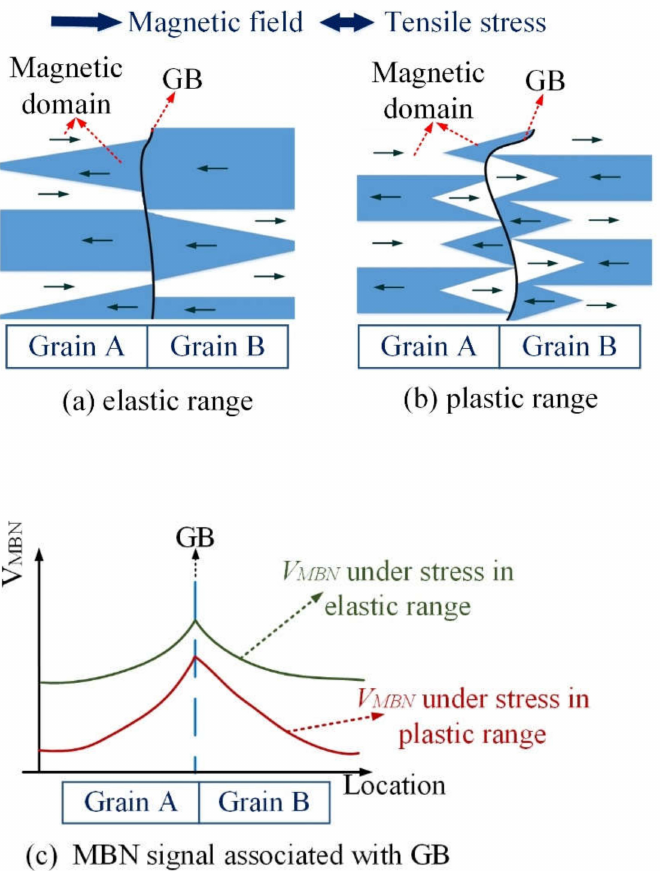
Figure 9. The schematic of domains interaction and MBN with GB under stress: ( a , b ) illustrate domain distribution around GB under stress in the elastic and plastic range, respectively; ( c ) illustrates MBN on the grain and GB under stress in the elastic and plastic